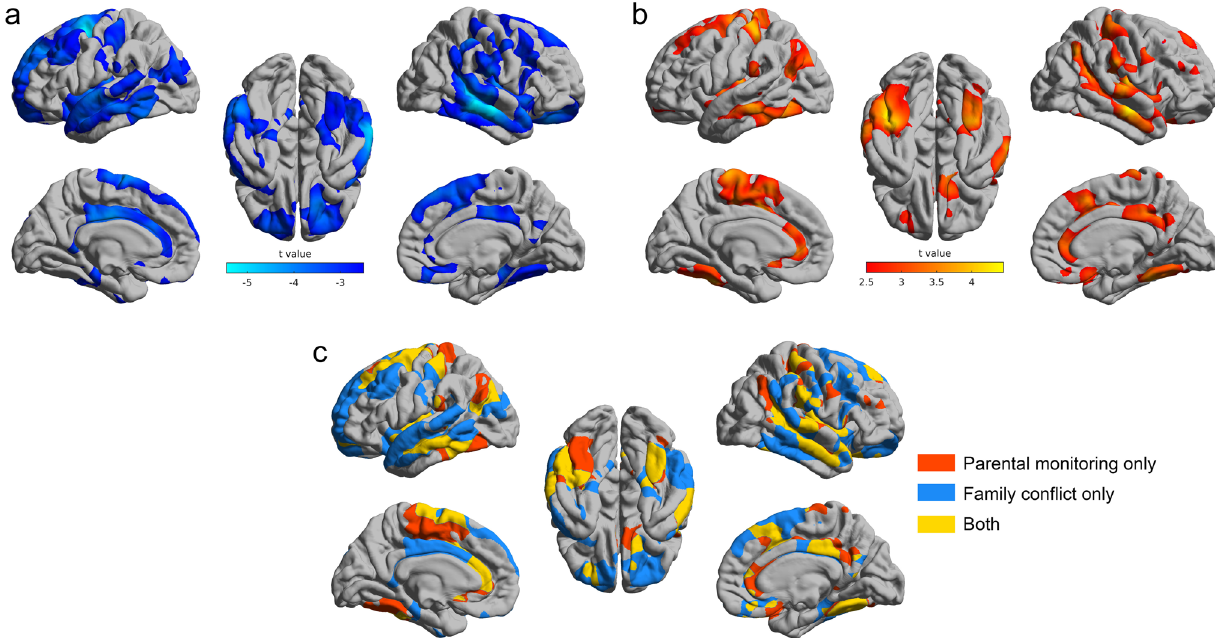
Fig. 2 The brain regions with their cortical areas correlated with the family con fl ict score and parental monitoring score. a The areas of brain regions that were signi fi cantly correlated with the family con fl ict score (FDR p < 0.05 corrected). The blue color indicates that lower surface areas were correlated with more severe family con fl ict scores. b The areas of brain regions that were signi fi cantly correlated with the parental monitoring score (FDR p < 0.05 corrected). The red color indicates higher surface areas were correlated with more positive parental monitoring. c The brain regions signi fi cantly (FDR p < 0.05 corrected) related to parental monitoring only (red color), family con fl ict only (blue color), and the brain regions correlated with both measurements (yellow